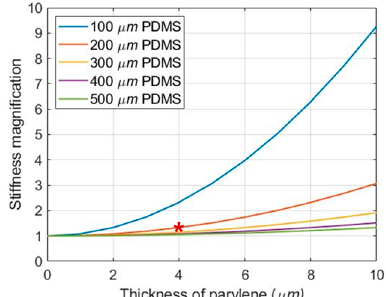
Figure 6. Magnification of the stiffness according to the thickness of parylene. The stiffness Figure6. Magnificationofthesti ff nessaccordingtothethicknessofparylene. Thesti ff nessmagnification magnification was obtained by dividing the total stiffness by the stiffness of each PDMS ( D tot / D PDMS ). was obtained by dividing the total sti ff ness by the sti ff ness of each PDMS ( D tot / D PDMS ). The red The red asterisk refers to the thickness of PDMS and parylene layer used in this paper. asterisk refers to the thickness of PDMS and parylene layer used in this